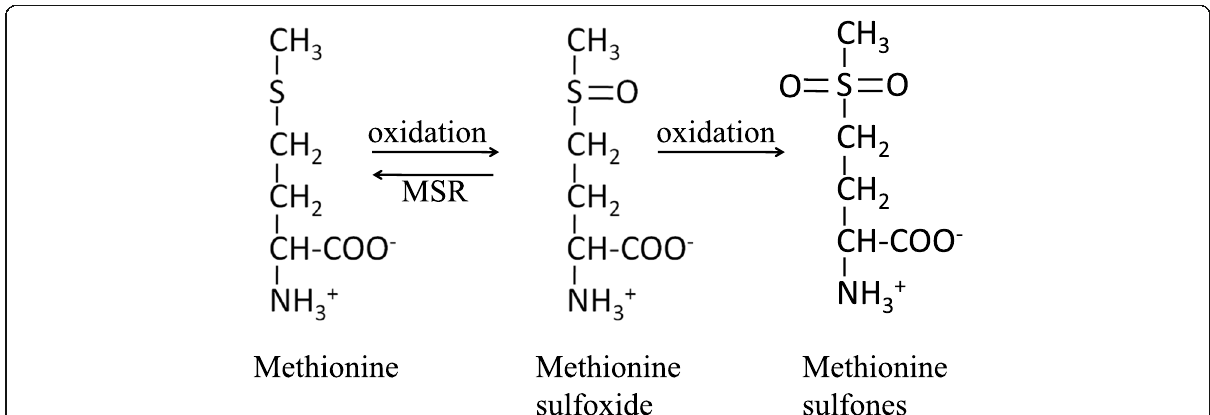
Fig. 4 Methionine sulfoxide (Met-SO) formation and repair by MSR: Under oxidative stress Met residues (free or protein bound) convert into Met- SO, further oxidation results in sulfone formation. MSR reductively repairs Met-SO to